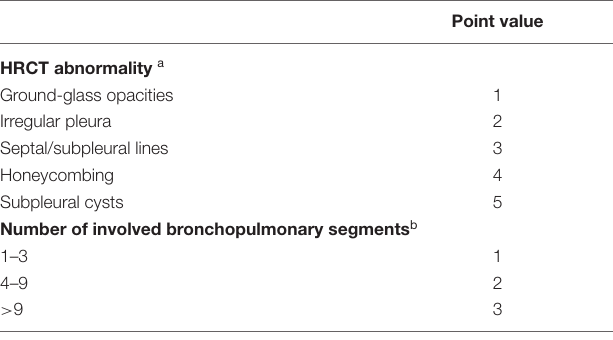
TABLE 1 | Warrick score for HRCT